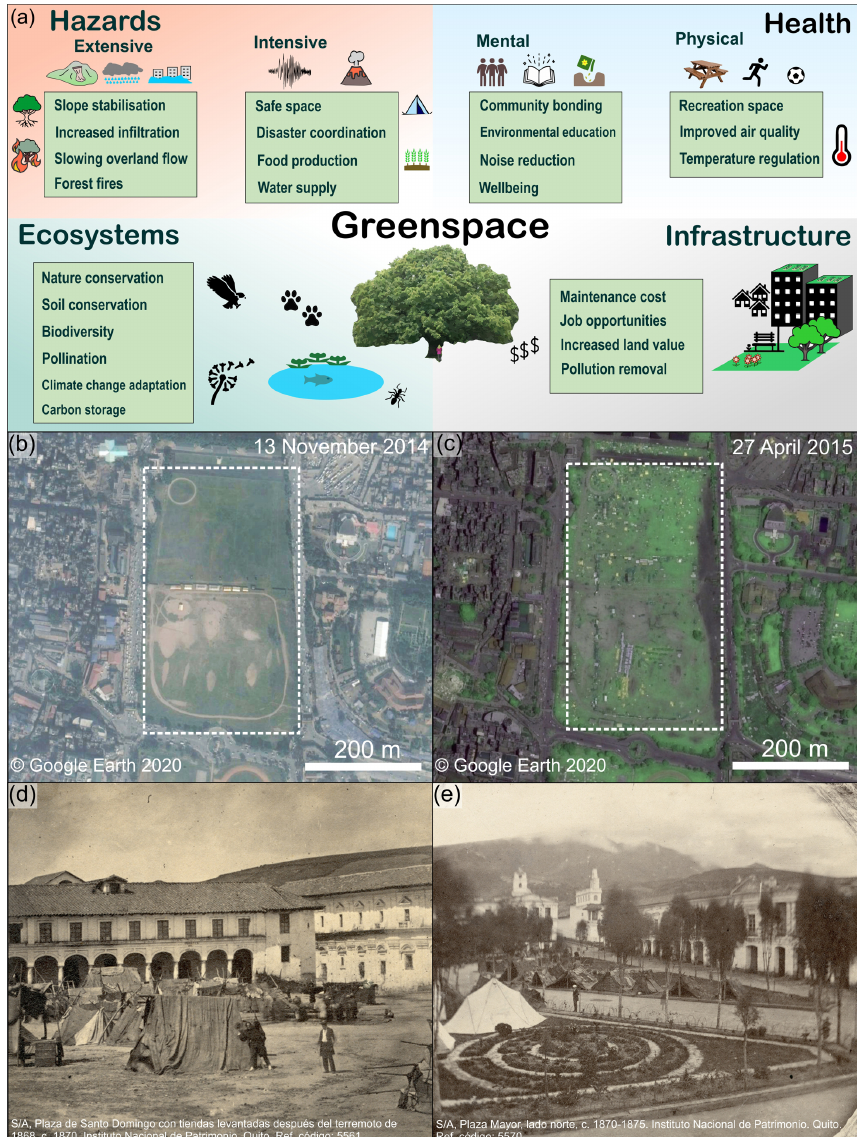
Figure 1. (a) Example impacts of urban greenspace on hazards, health, ecosystems, and infrastructure. (b–c) An area of greenspace, “Tundikhel” (lat 27.702 ◦ , long 85.315 ◦ ), in Kathmandu, Nepal, which was used for temporary tented accommodation following the Gorkha earthquake (25 April 2015). (d–e) Tents in Plaza Santo Domingo and Plaza Mayor (Plaza Grande) in Quito after the 1868 Ibarra